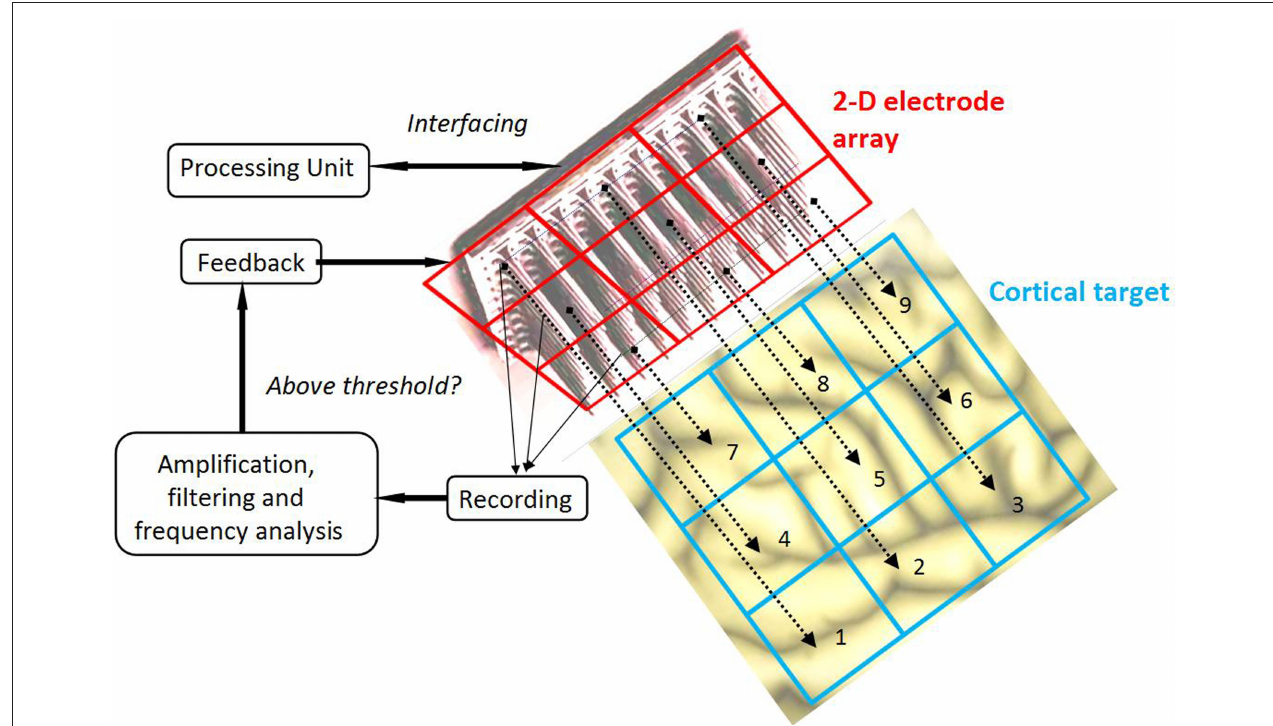
filtered and analyzed to detect the presence of undesirable frequency components above a predetermined threshold. Stimulation is provided to the cortical target only at the spatial position(s) where the threshold is